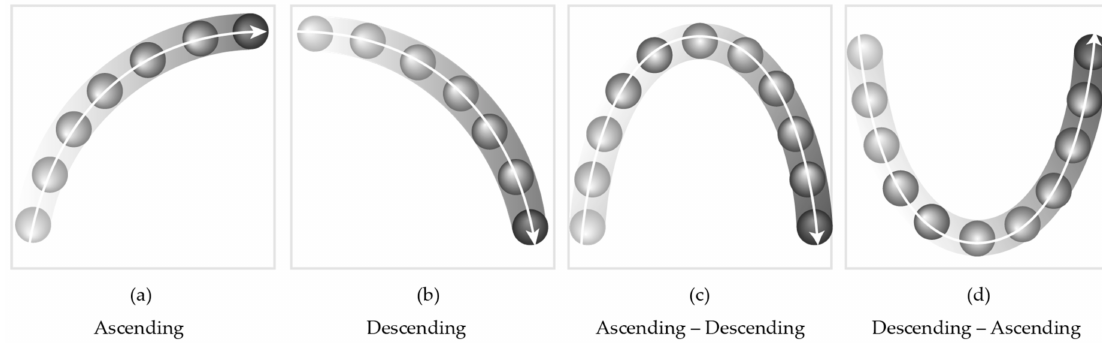
Figure 2. The contours of visual